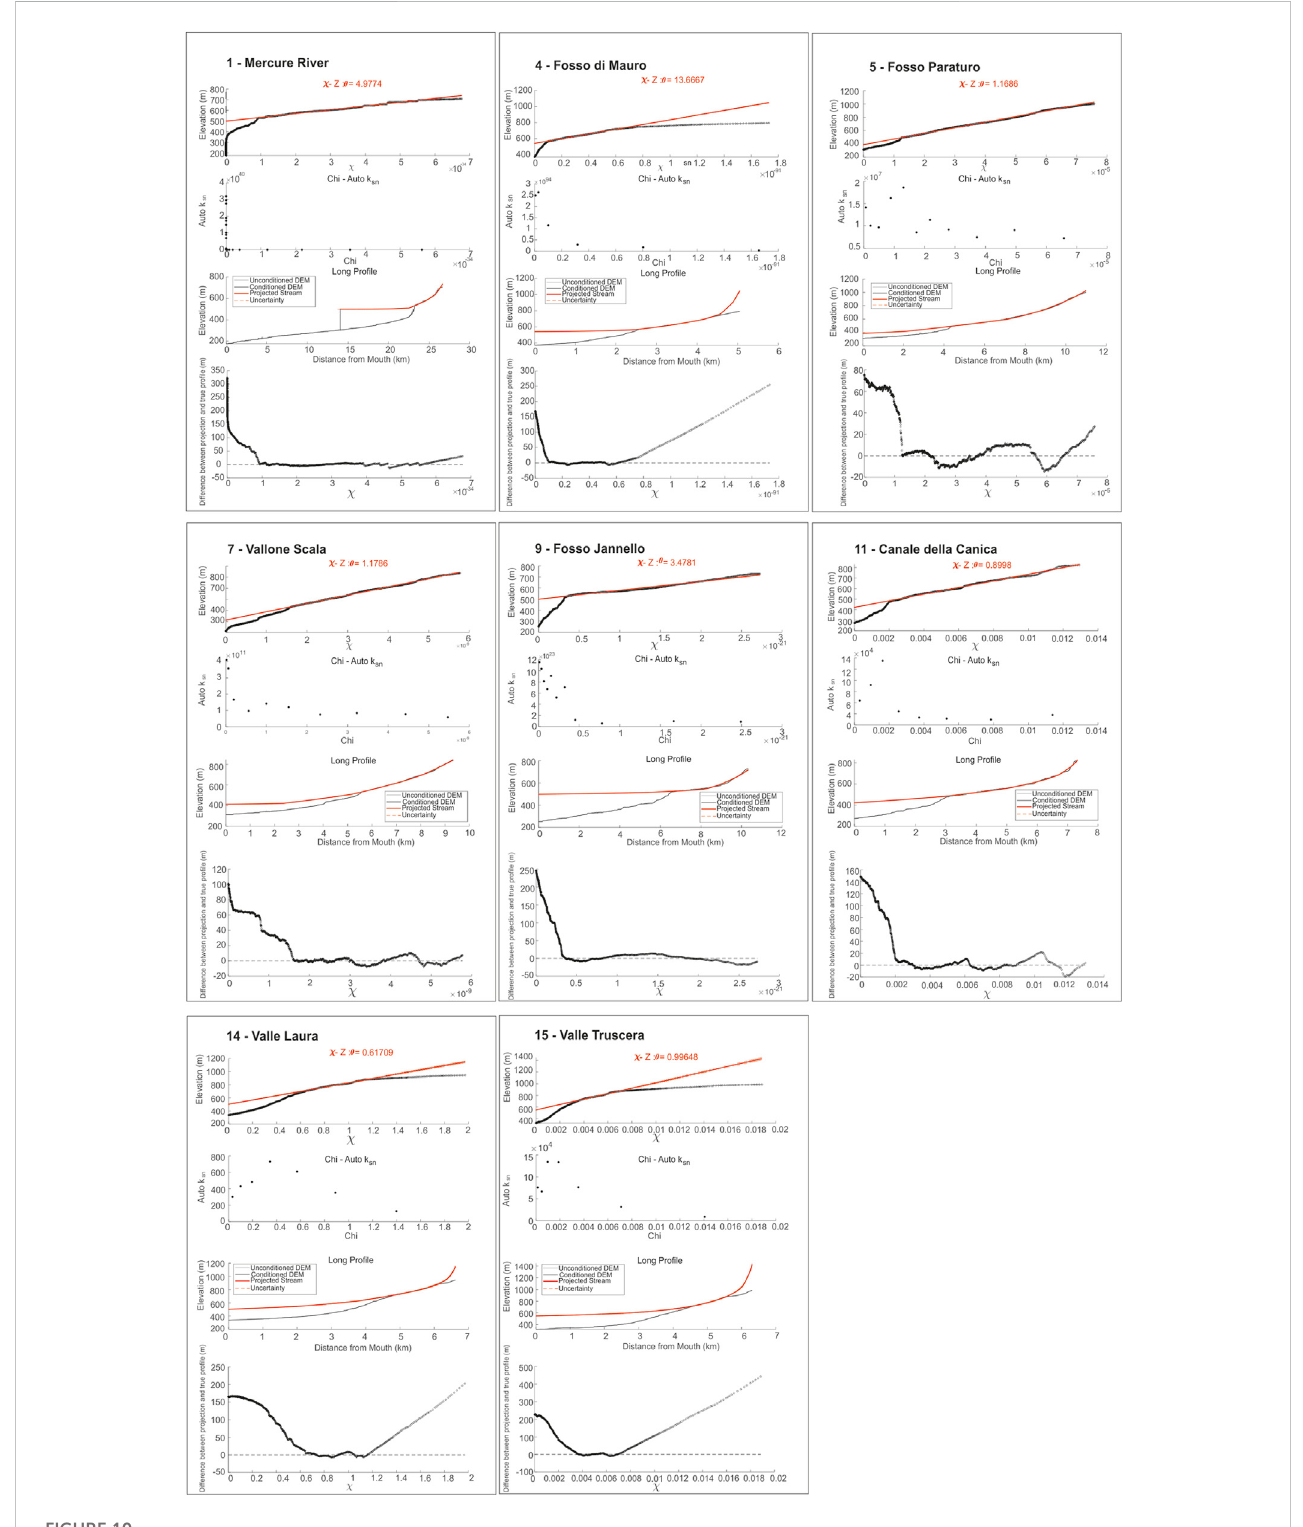
FIGURE 10 Reconstruction of the incision depth from transient segments of selected channels of the study area.